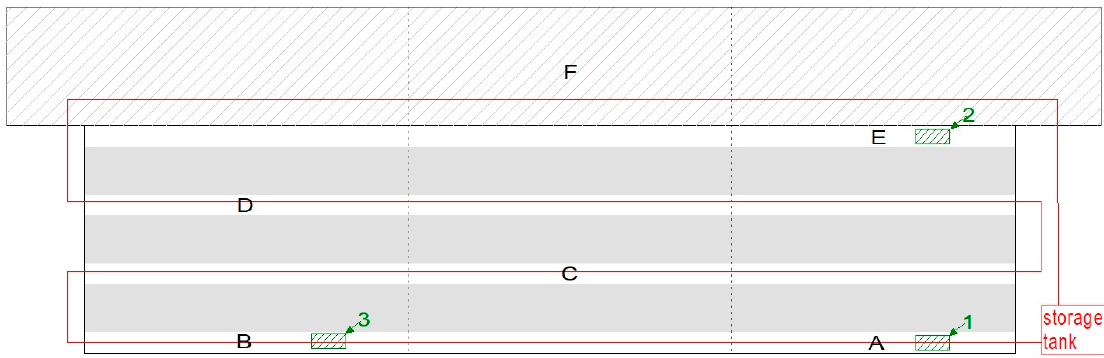
Figure 1. Top view of the stable with three aviary systems (solid grey bars) and a winter garden (hatched grey area), divided in sections (dashed lines). The automatic enrichment device (red line) led along three corridors through the stable and along the winter garden. Points for scoring (A–F) and the three fields of behavioral observations (ScA 1–3, hatched green areas) are also shown. ScA: scratching areas, ScA 1 and ScA 3: scratching areas beneath an enrichment device, ScA 2: similar scratching area without the device.